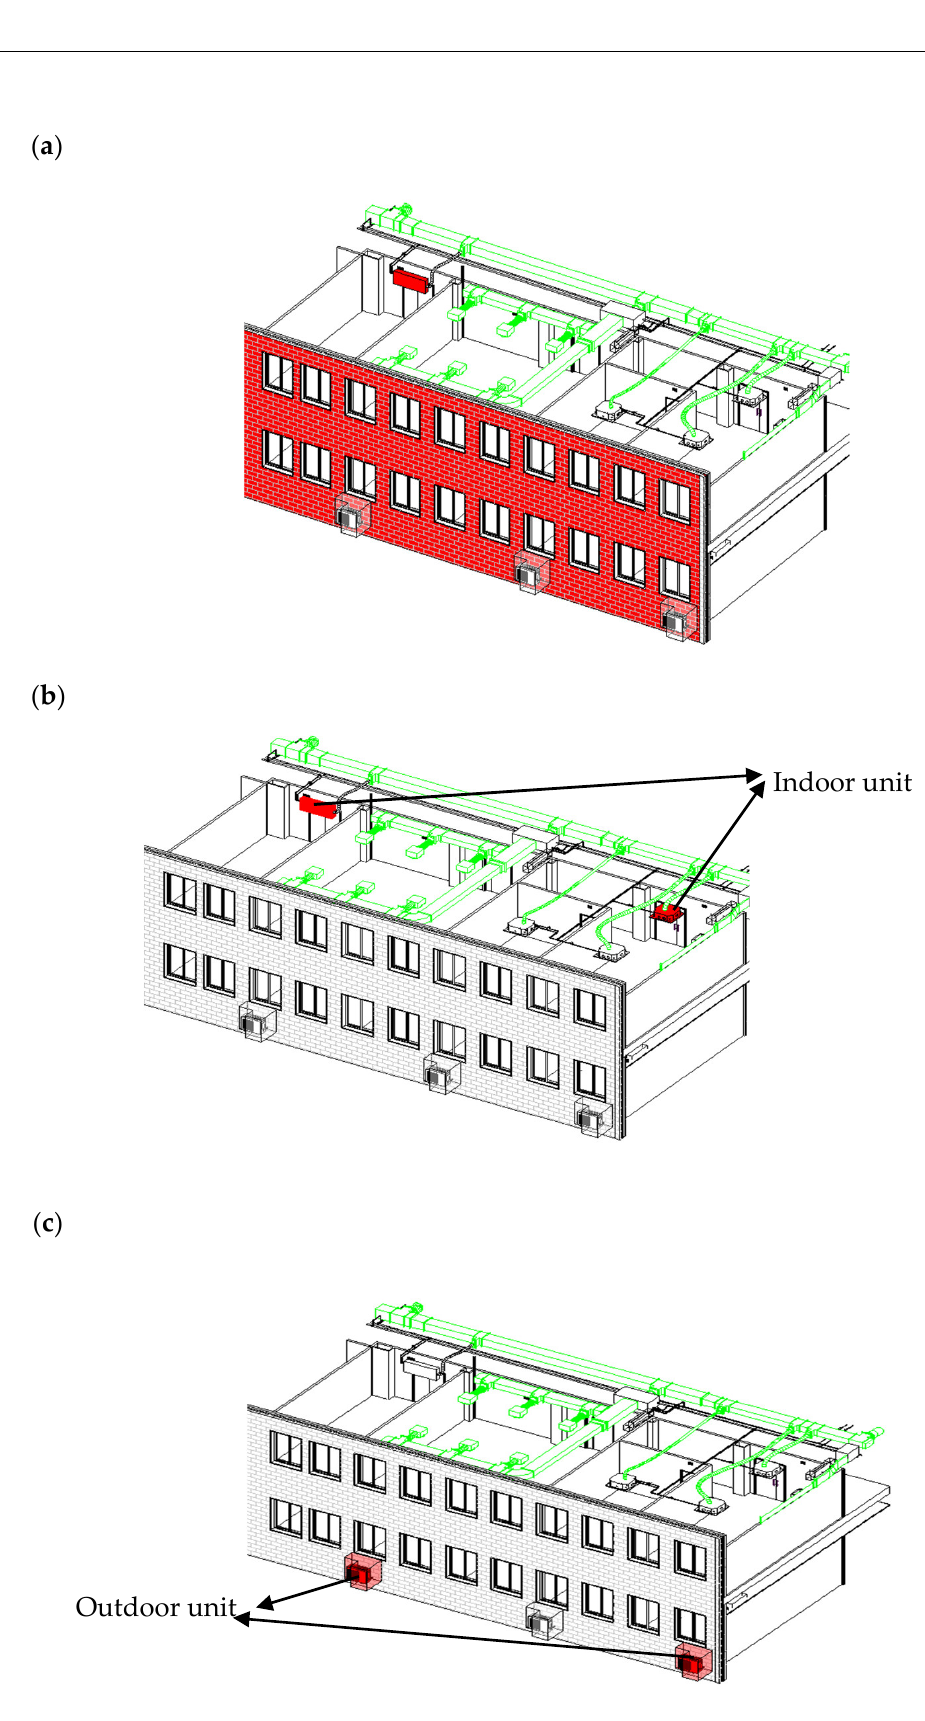
Figure 4. The BIM visualization of malfunction HVAC equipment: ( a ) an under design of the indoor unit, ( b ) a malfunctioning of the indoor unit, and ( c ) a malfunctioning of the outdoor unit.